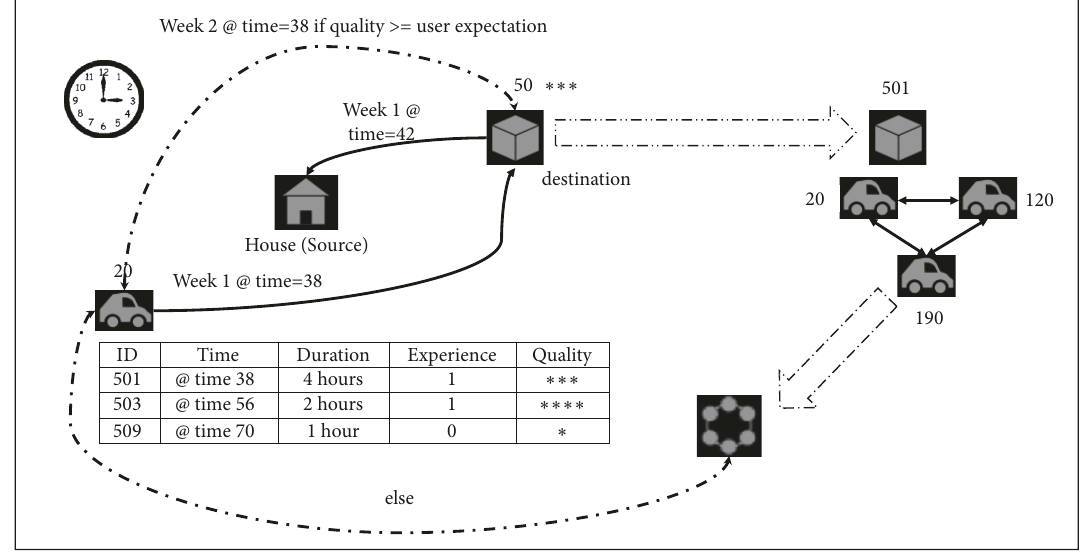
Figure 1: A schematic representing the process of plan execution by an